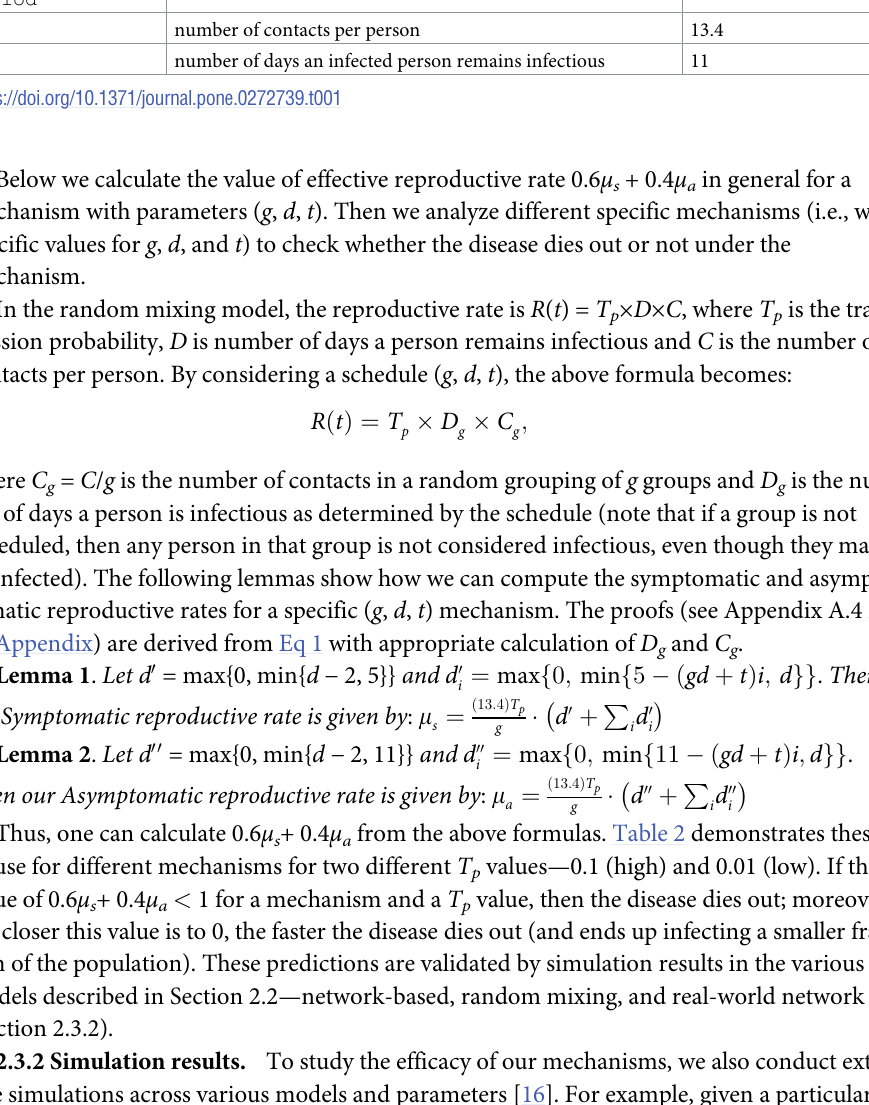
Table 2. Values of 0.6 μ